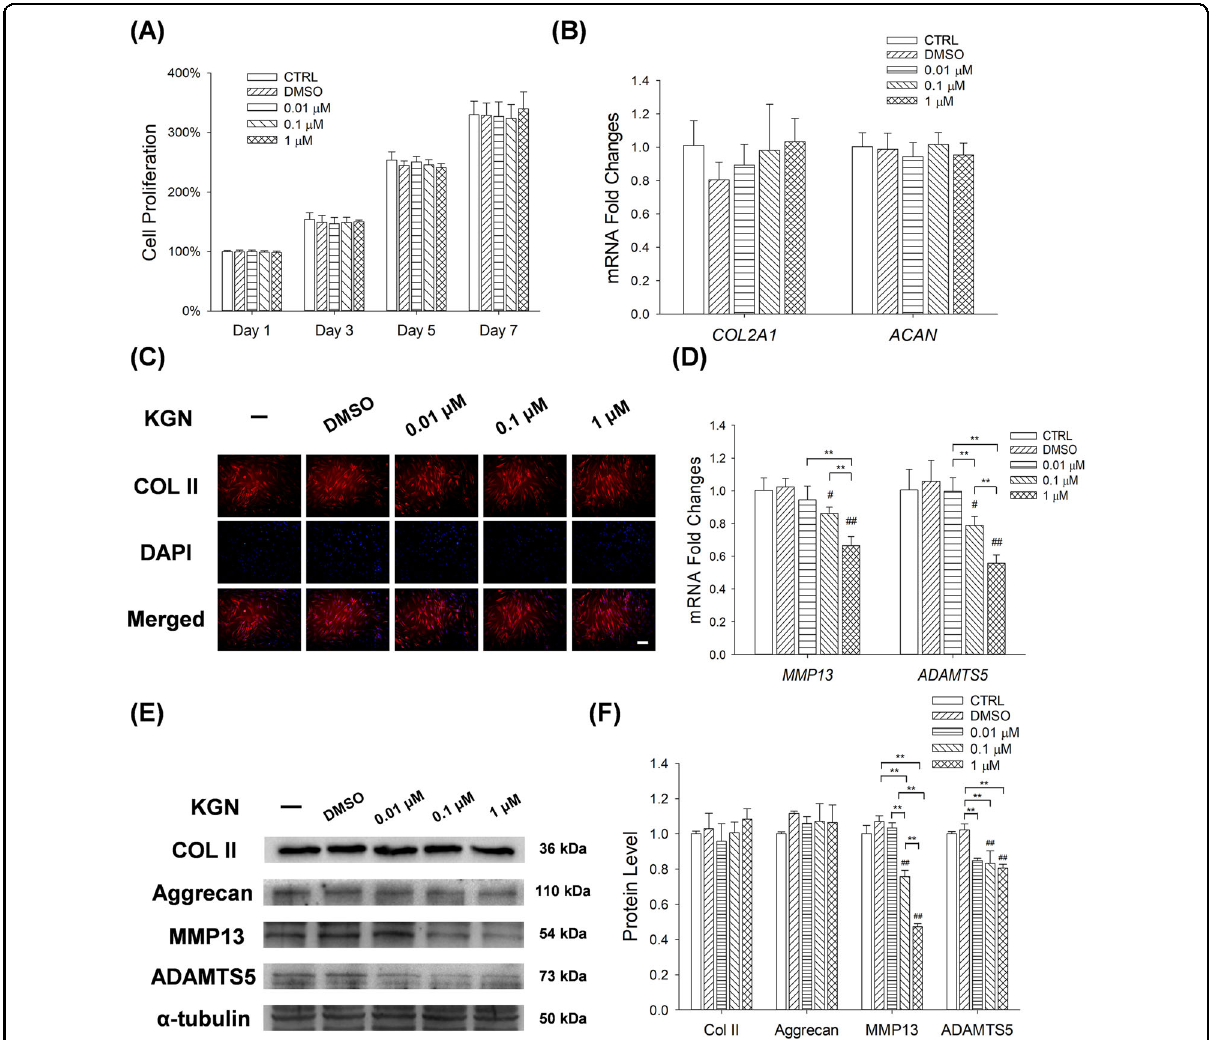
Fig. 1 The effects of KGN on proliferation as well as anabolic and catabolic metabolism of human articular chondrocytes. A Proliferation of chondrocytes after 1, 3, 5 and 7 days of KGN treatment. B RT-PCR analysis for the expression of COL2A1 and ACAN mRNA levels in chondrocytes after KGN treatment. C Immuno fl uorescence analysis for the expression of COL II proteins in KGN-treated chondrocytes. Scale bar = 100 μ m. D RT-PCR analysis for the expression of MMP13 and ADAMTS5 mRNA levels in chondrocytes after KGN treatment. E – F The effects of KGN on the protein levels of COL II, aggrecan, MMP13 and ADAMTS5 in normal chondrocytes were determined using Western blot assays. Cells were treated with 0.01 μ M, 0.1 μ M or 1 μ M of KGN. Values represent mean ± S.E.M of six replicas for cell proliferation assays, four replicas for RT-PCR experiments and three replicas for Western blot assays, respectively. (* p < 0.05 and ** p < 0.01; between the indicated groups and # p < 0.05 or ## p < 0 . 01 versus the CTRL